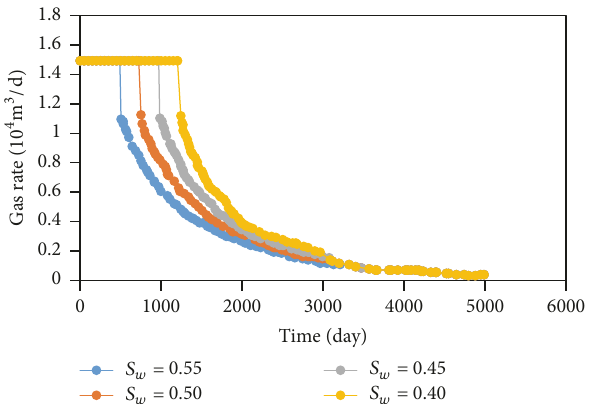
Figure 16: Effect of water saturation on gas production.